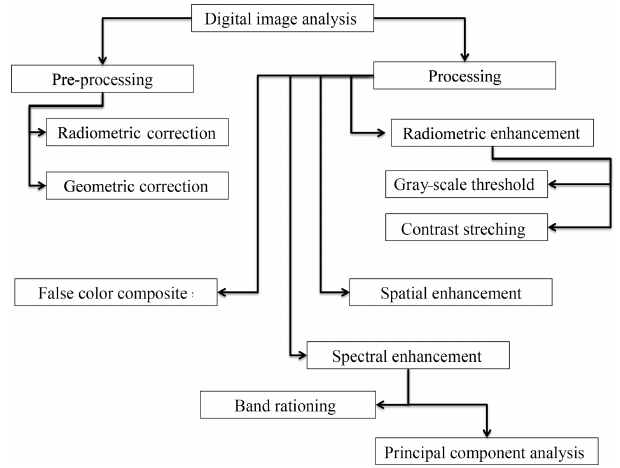
Figure 2. Workflow of digital image analysis.